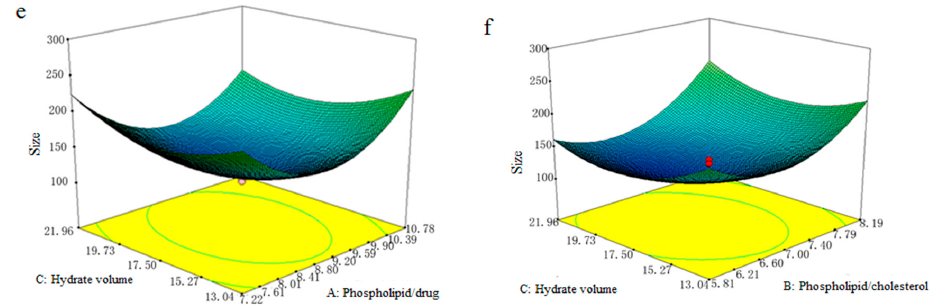
Figure 3. ( a ) 3D response surface plots for the influence of the phospholipid/drug ratio and phospholipid/cholesterol ratio on EE; ( b ) 3D response surface plots for the influence of the phospholipid/drug ratio and hydrate volume on EE; ( c ) 3D response surface plots for the influence of the phospholipid/cholesterol ratio and hydrate volume on EE; ( d ) 3D response surface plots for the influence of the phospholipid/drug ratio and phospholipid/cholesterol ratio on size; ( e ) 3D response surface plots for the influence of the phospholipid/drug ratio and hydrate volume on size; ( f ) 3D response surface plots for the influence of the phospholipid/cholesterol ratio and hydrate volume on size.